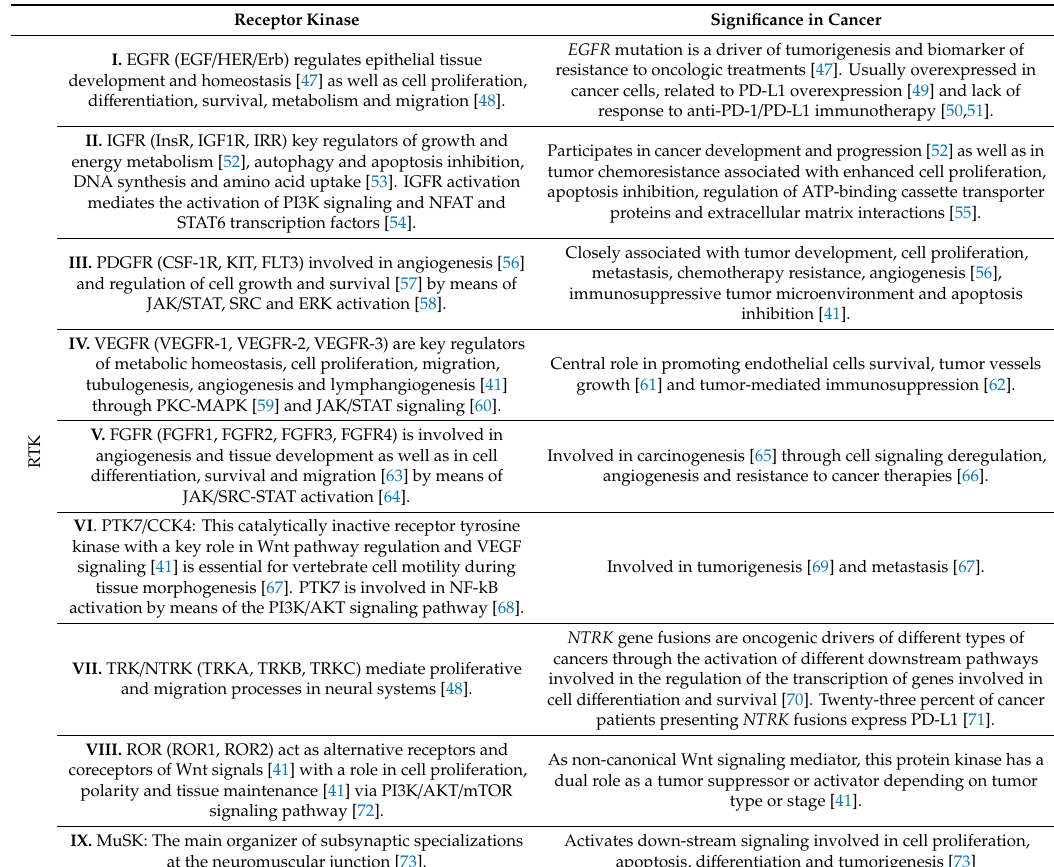
Table 2. Receptor kinases classification and role in cancer. Receptor Kinase Significance in